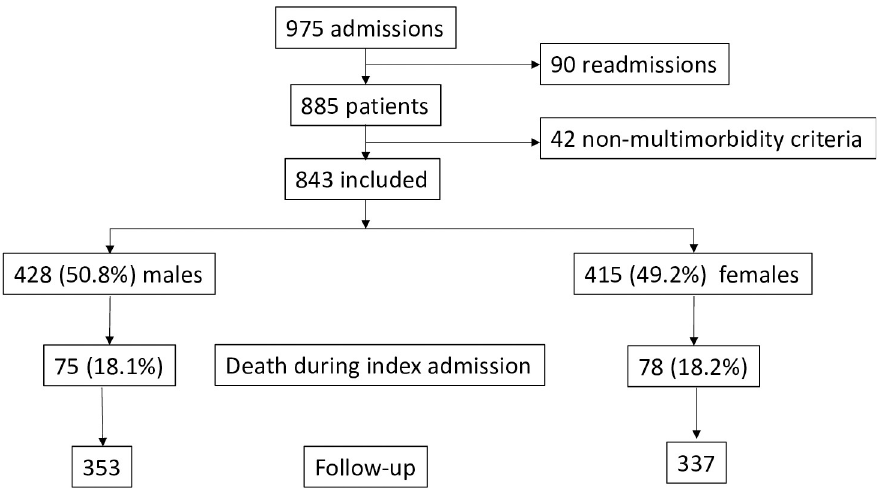
Fig 1. Flowchart of